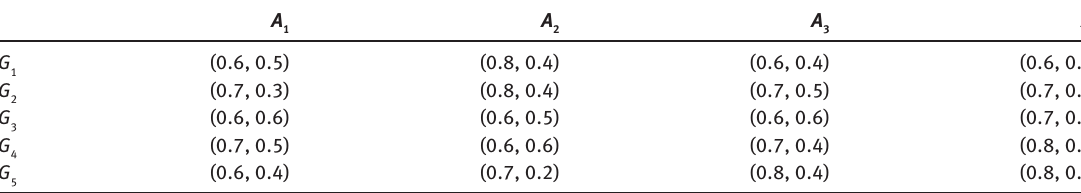
Table 2: Pythagorean Fuzzy Decision Matrix D 2 .